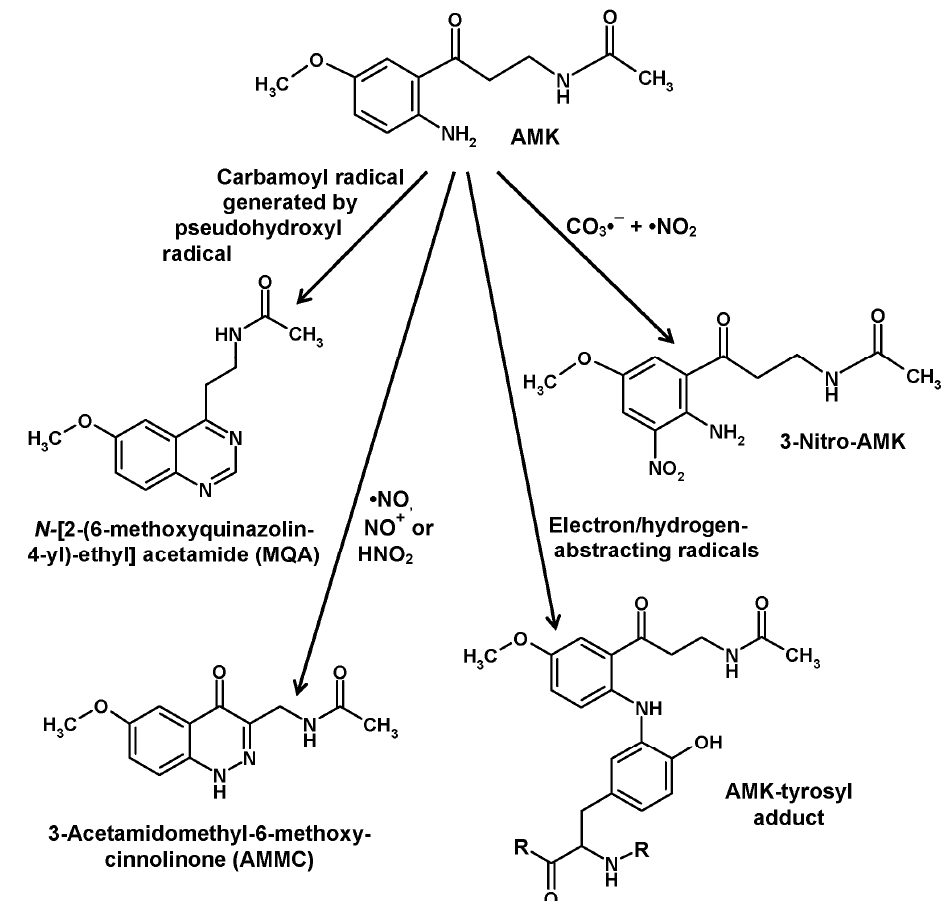
Figure 5. Various nonenzymatic reactions of N 1 -acetyl-5-methoxykynuramine (AMK). The AMK-tyrosyl adduct, as it was concluded to occur in some proteins, was deduced from interactions of AMK with the tyrosine side chain fragment, 4-ethylphenol [139]. Additionally, electron/hydrogen-abstracting radicals led to the formation of several chemically identified AMK dimers and oligomers [138] and to noncharacterized products formed by interaction with tryptophan